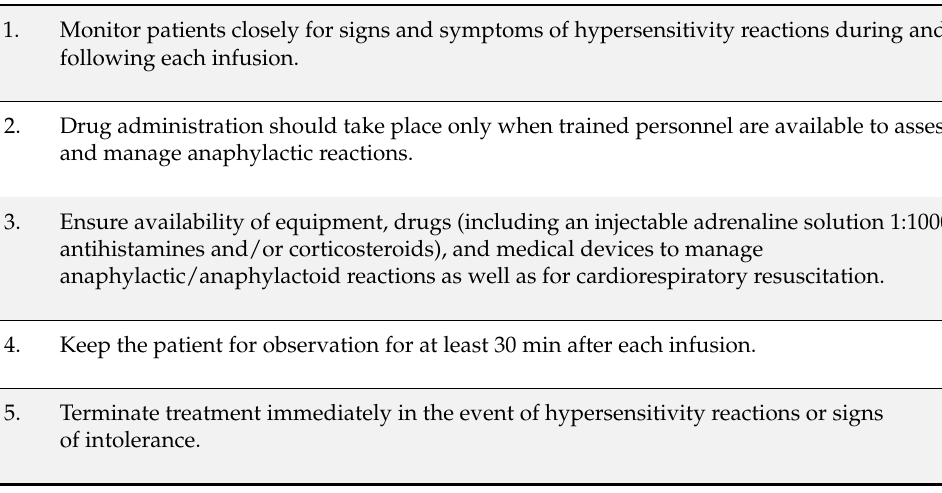
Table 1. Safety recommendations for intravenous iron therapy.